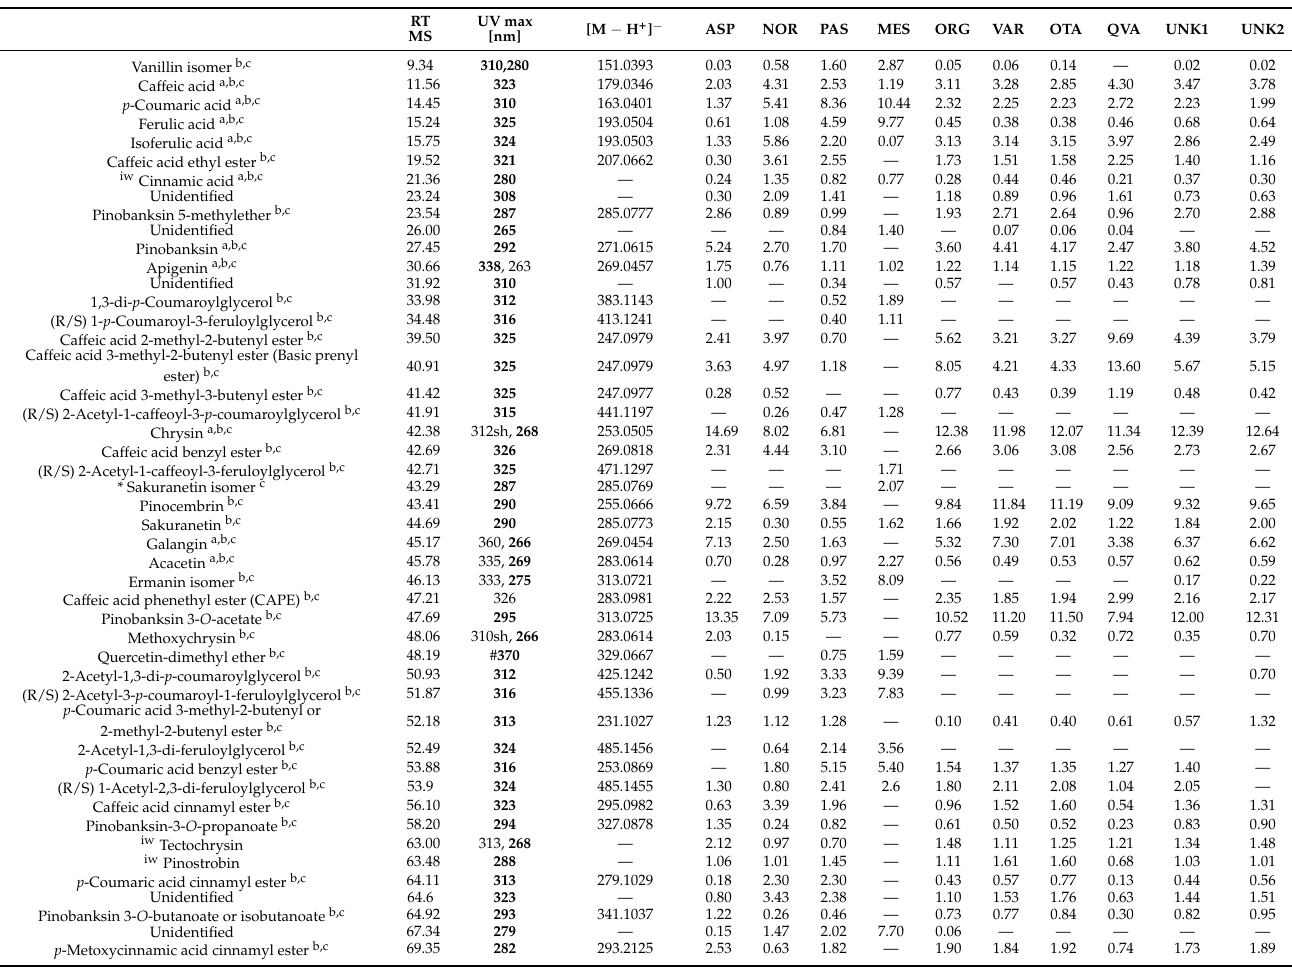
Table 3. Main components of Georgian propolis extracts †